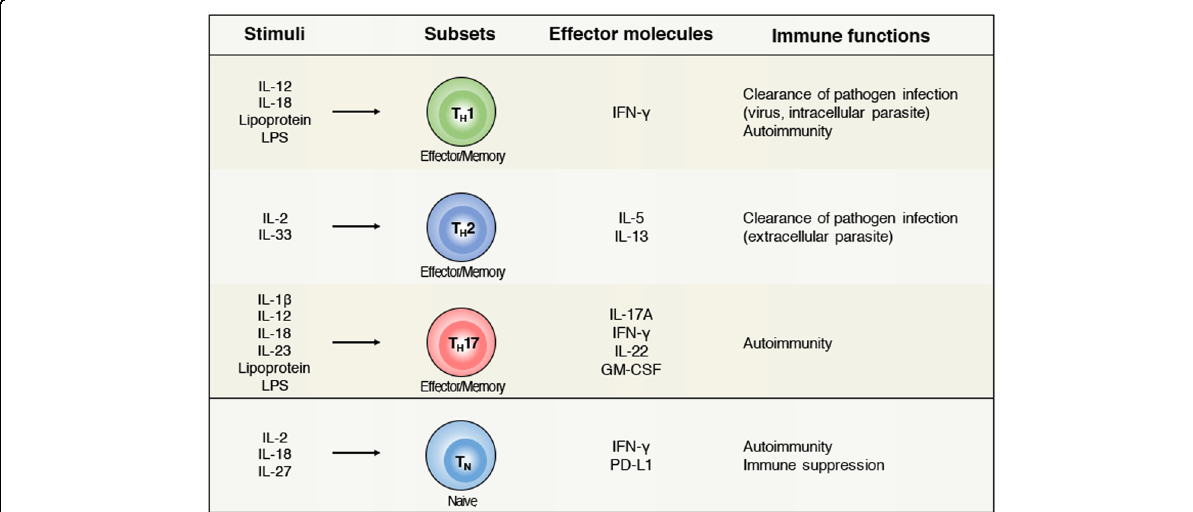
Fig. 2 Stimulatory molecules for antigen-independent bystander activation and functioning of CD4 + T cells. Effector/memory CD4 + T cells (T H 1, T H 2, and T H 17) can undergo bystander activation by directly responding to in fl ammatory cytokines and TLR agonists. These signals induce effector cytokine production that promotes important pathological responses in autoimmunity and pathogen infections. Naïve CD4 + T cells can also be activated in a TCR-independent manner under the in fl uence of cytokines such as IL-2, IL-18, and IL-27. Bystander activation of naïve CD4 + T cells can promote immunosuppressive functions that regulate autoimmune pathogenesis. IL interleukin, IFN- γ interferon- γ , GM-CSF granulocyte- macrophage colony-stimulating factor, PD-L1 programmed death-ligand 1, LPS lipopolysaccharide, T H 1 T-helper 1, T H 2 T-helper 2, T H 17 T-helper 17, T N naïve CD4 + T